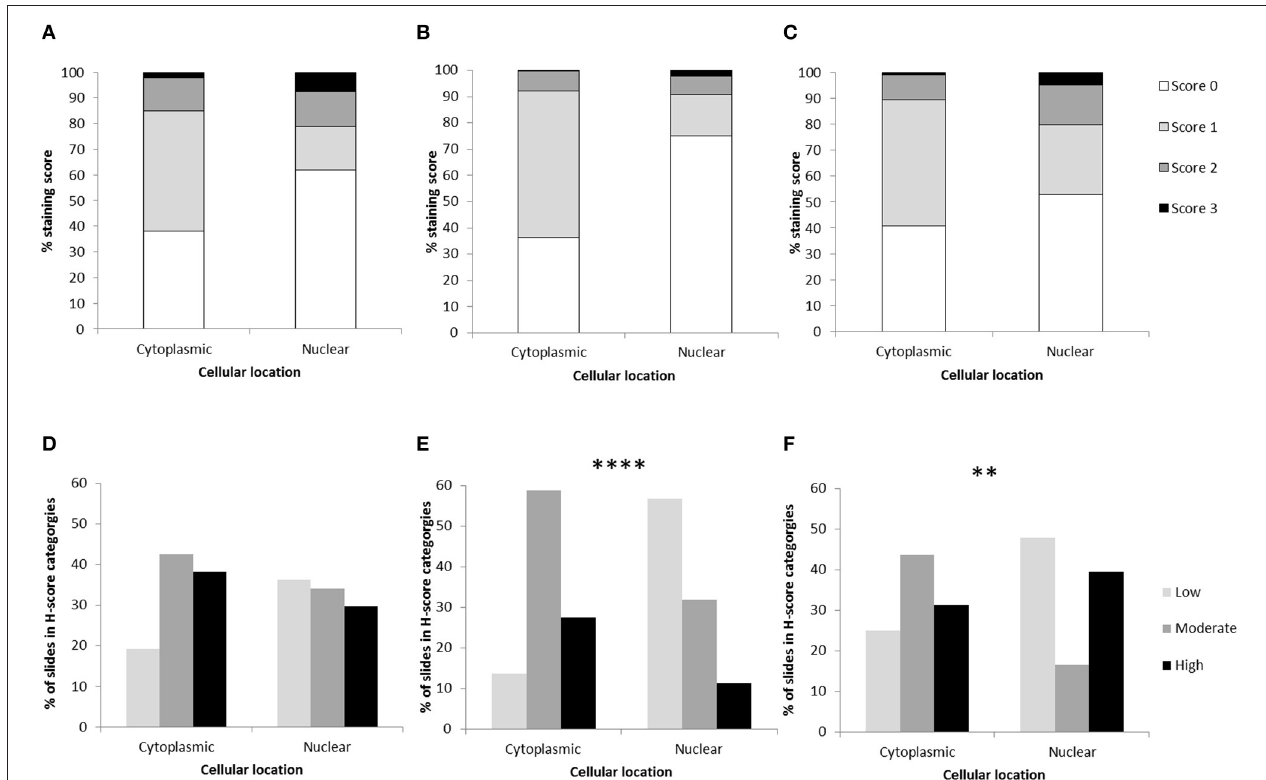
FIGURE 1 | Osteosarcoma H-scores in the cytoplasm and nucleus following immunohistochemical staining. Average H-scores for (A) GLUT1, (B) MMP3, and (C) NRF2. H-score distributions across samples for (D) GLUT1 ( P > 0.05), (E) MMP3 (**** P < 0.0001), and (F) NRF2 (** P = 0.008). Differences between nuclear and cytoplasmic staining were assessed using chi-square.